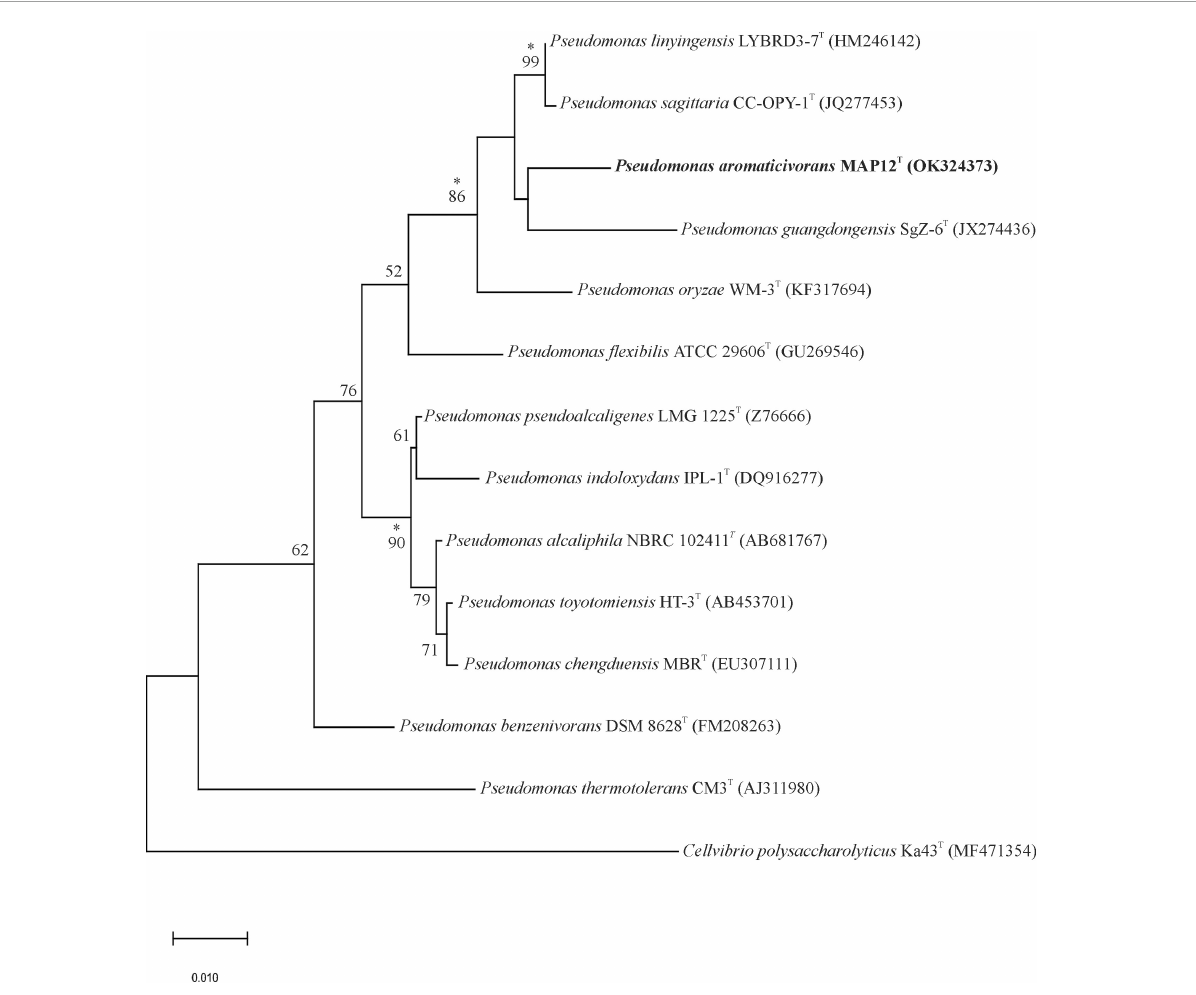
FIGURE2 Maximum-likelihood tree based on 16S rRNA gene sequences showing the phylogenetic relationships between strain MAP12 T and related taxa. Bootstrap values are shown as percentages of 1000 replicates. Branches signed with an asterisk occurred with every tree-making algorithm used in the study. Cellvibrio polysaccharolyticus Ka43 T was used to root the tree. Bar, 0.01 substitution per nucleotide